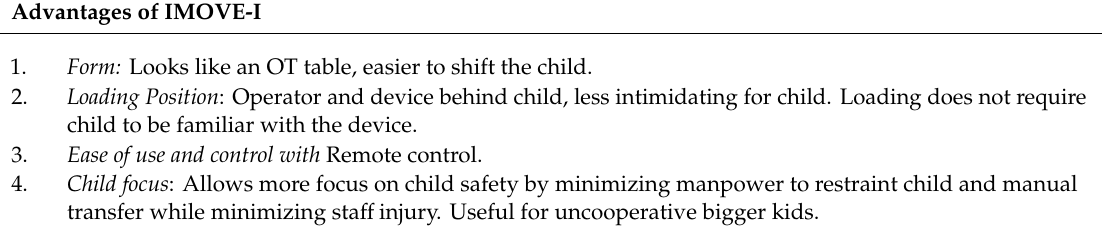
Table 3. Summary of advantages of IMOVE-I and IMOVE-II